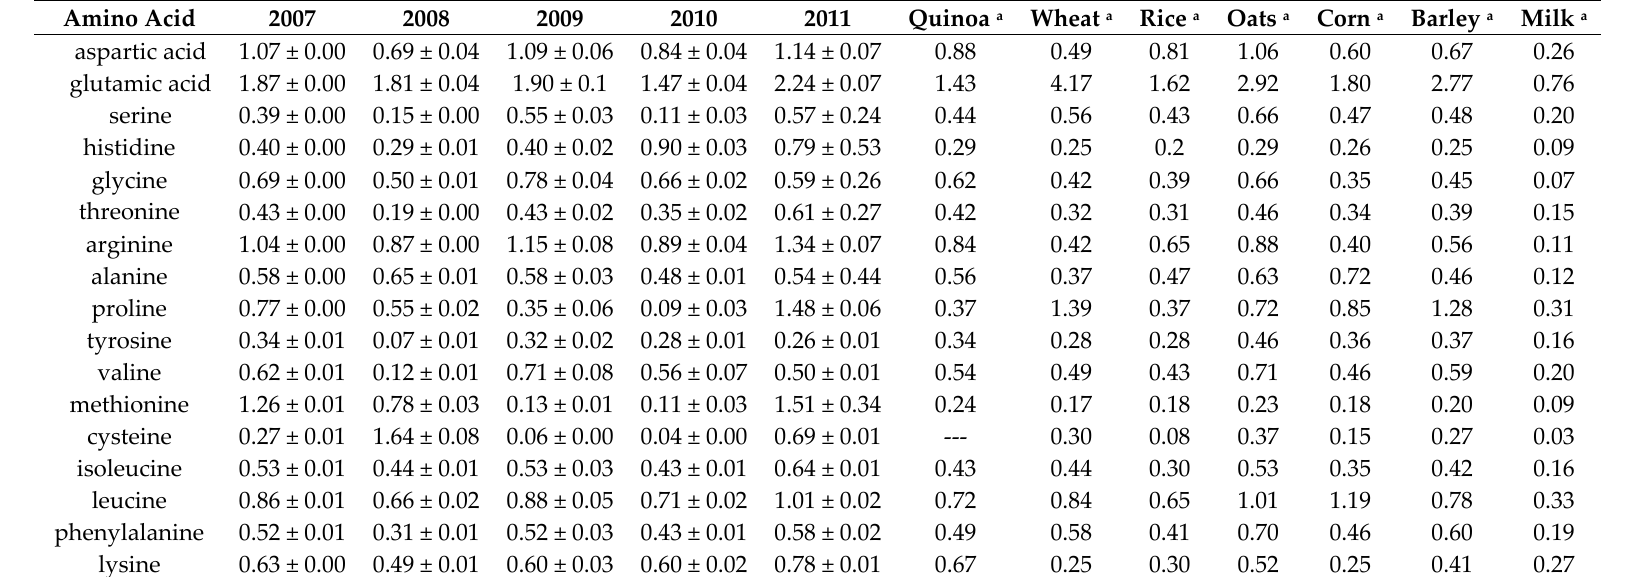
Table 2. Amino acid profiles of western quinoa